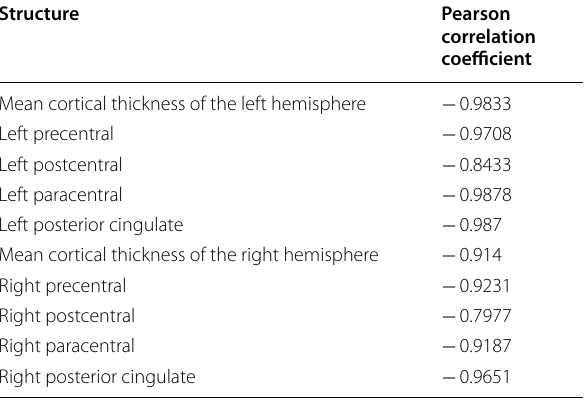
Table 7 The correlation coefficient values demonstrating the correlation between cortical thickness and EDSS scores